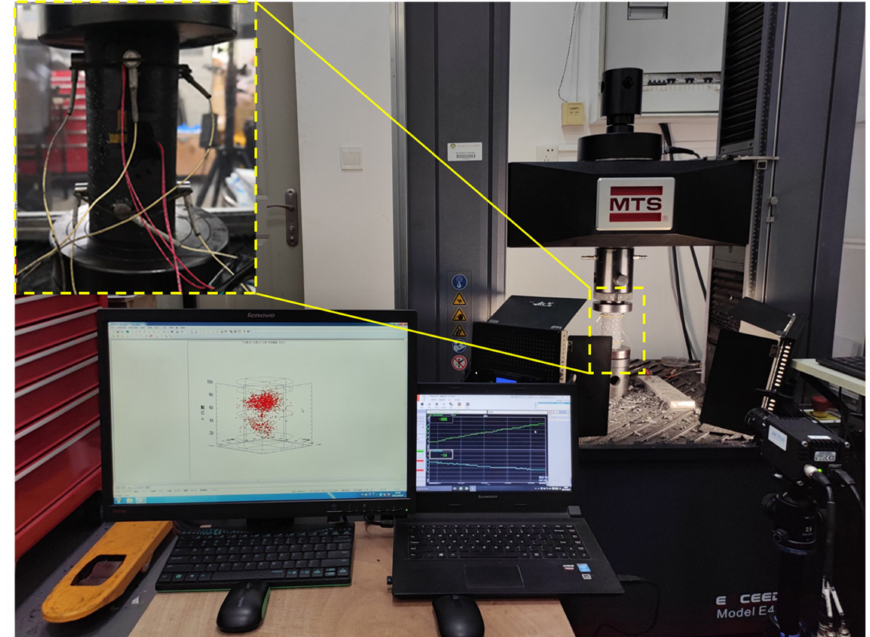
Figure 2. Experimental system.